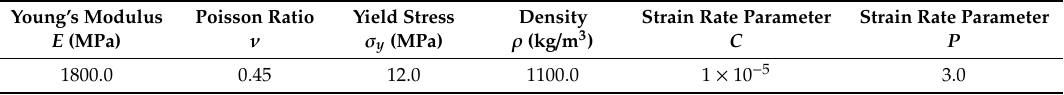
Table 3. Material constants of the applied constitutive model of the PLGA bioresorbable polymer. Young’s Modulus E